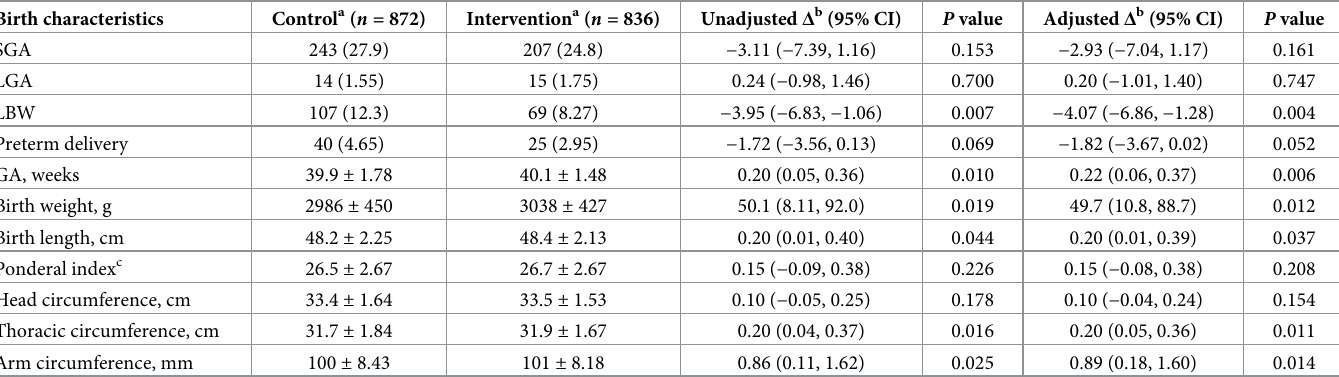
Table 4. Efficacy of prenatal BEP supplementation on birth outcomes.